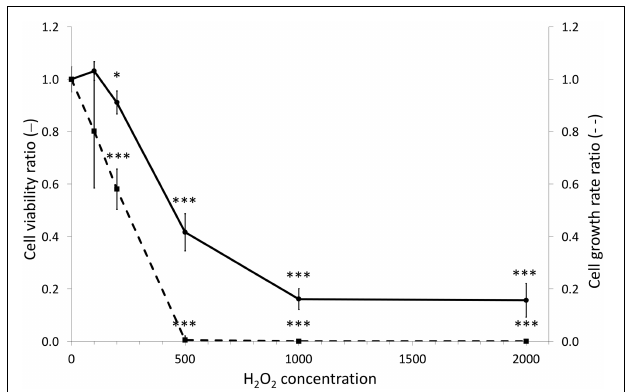
FIGURE 4 | Quantification of intracellular ROS in gastrodermal cultivated cells under H 2 O 2 treatments. Intracellular content of ROS was measured by staining cells with CellROX Green Reagent after 1 h, 2 h, 6 h, 1 day, or 7 days with 0 µ M H 2 O 2 (control condition; white bars), 200 µ M H 2 O 2 (gray bars) or 500 µ M H 2 O 2 (black bars). Results represent the percentage of fluorescent cells (CellROX-positive cells), within the population of interest, quantified by flow cytometry. Data are represented as means with standard error bars. Significant differences between control and treatments are expressed by ∗ p < 0.05 and ∗∗∗ p <